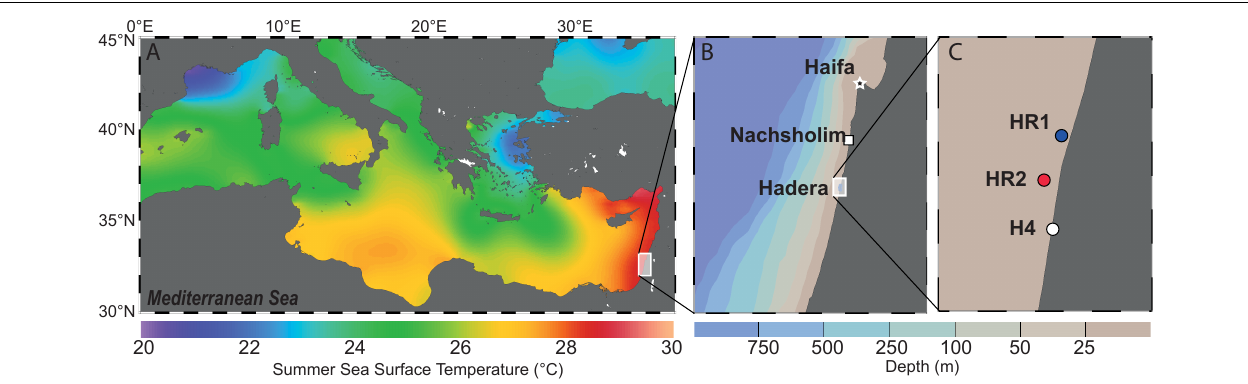
FIGURE 1 | (A) Summer Sea Surface Temperatures (SST) in the Mediterranean Sea. The background shows the mean annual SST extracted from the World Ocean Atlas 2013 (Locarnini et al., 2013) and was generated with Ocean Data View (Schlitzer, 2016). (B) Israeli coastline showing the two sampling areas. The background shows depth distribution of the sea floor generated with Ocean Data View (Schlitzer, 2016). (C) Detailed view of the three locations near the Hadera power plant. HR1, HR2 (R stands for ridge, depth 5–7m) and H4 (depth 0.5 – 2 m).